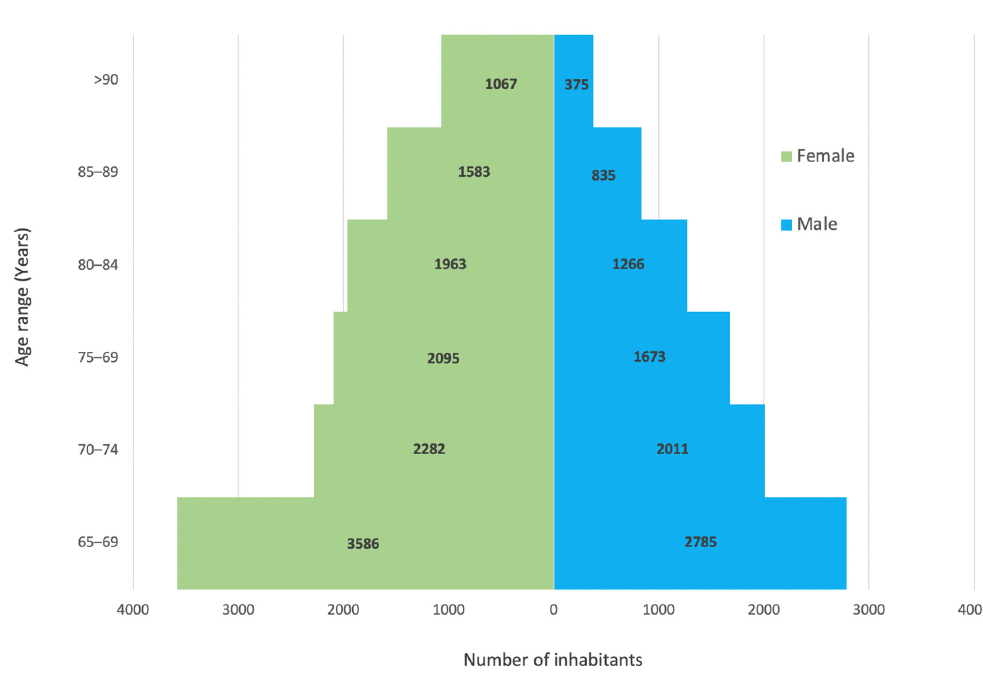
Figure 1. Age pyramid of the pooled population ≥ 65 years old of the 3 screened communities.